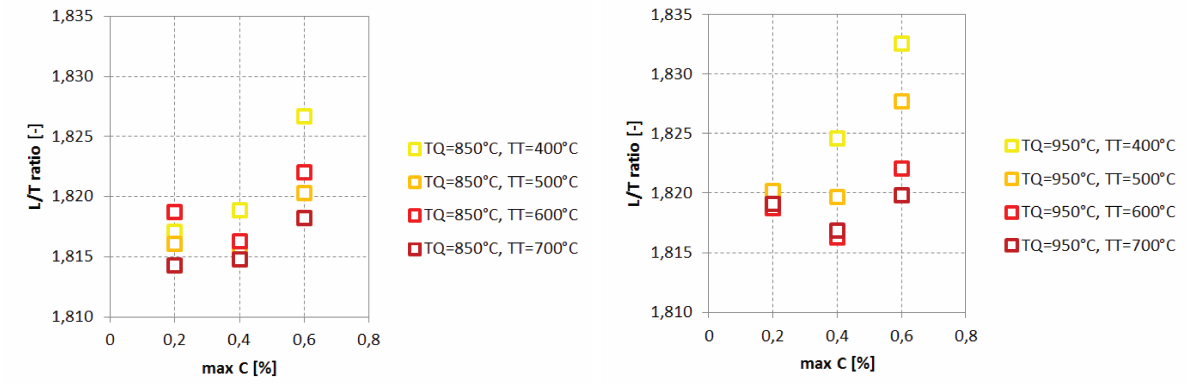
Figure 5. Measured L/T ratio values grouped by tempering temperatures. The L/T ratio values decreased for with increasing tempering temperature for all, C16E (max C = 0.2%), C35 (max C = 0.4%) and C55 (max C = 0.6%) and quenching temperatures T Q = 850 °C (left) and T Q = 950 °C